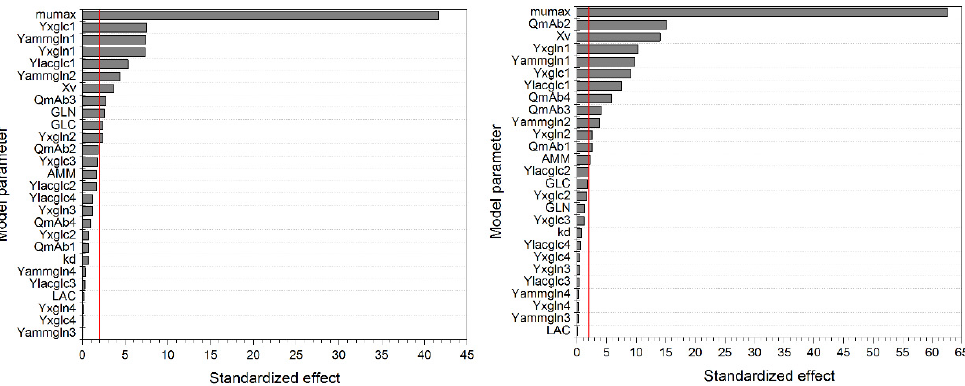
Figure 3. Pareto diagram of standardized effects for the determination of significant model parameters on the response of maximum viable cell concentration X V,max (left) and maximum antibody concentration mAb max (right). The vertical red line depicts the reference line for statistical significance, which is 1.98 for both model variables. The level of significance α was 0.05 for both model variables. Numbers indicate model parameter used in respective phase: 1, lag; 2, exponential; 3, stationary; 4, decline.